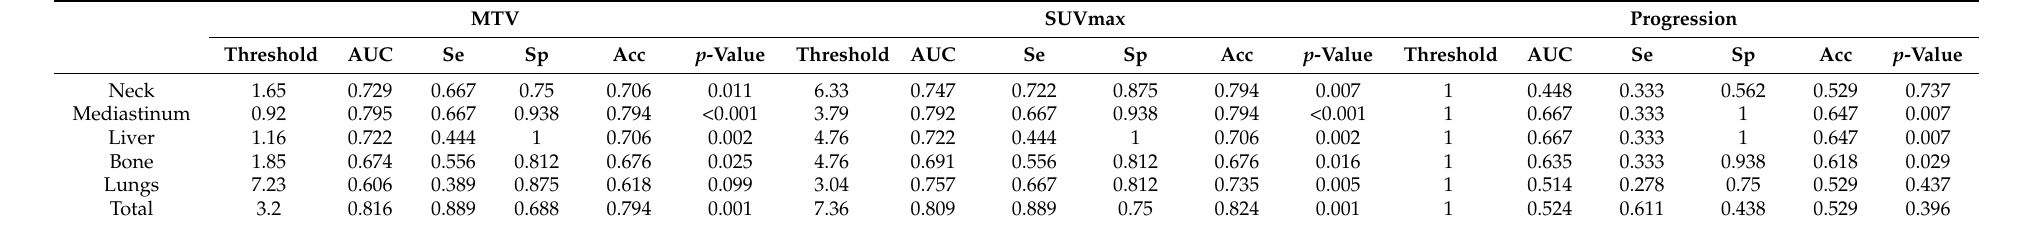
Table 4. Diagnostic performance of parameters measured on 18FDG PET/CT for 5-year overall survival using a ROC analysis. AUC: area under the curve, Se: sensitivity, Sp: specificity, Acc: accuracy. MTV